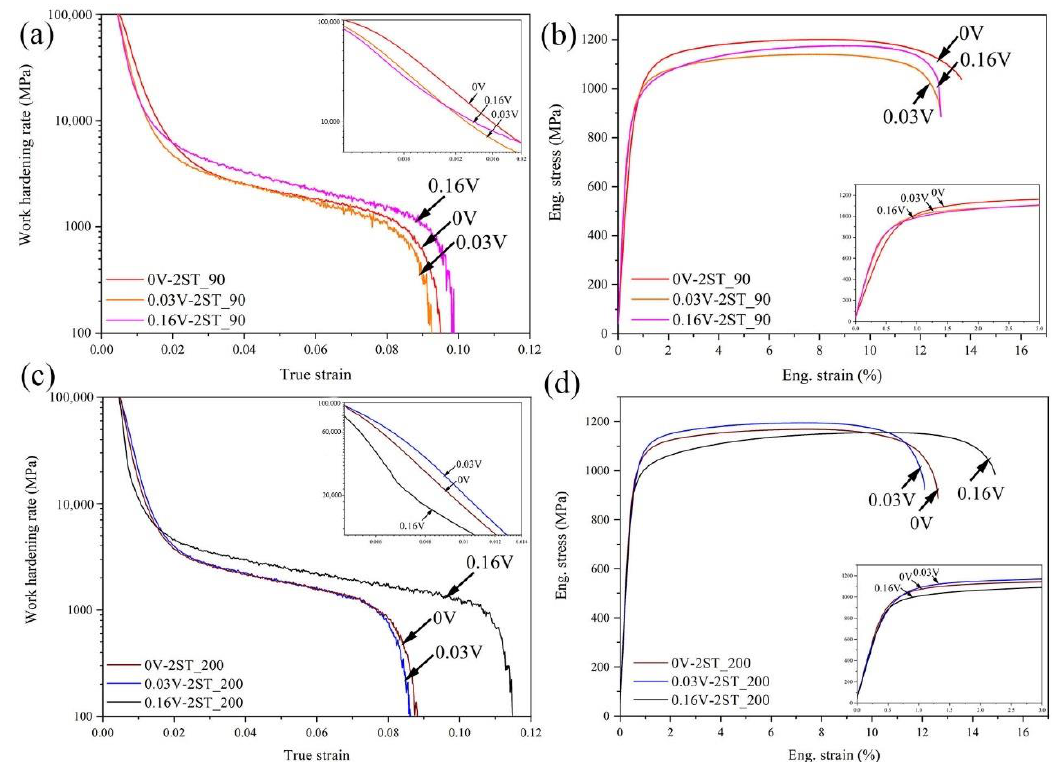
Figure 16. Comparisons of ( a , c ) true strain–work hardening rate and ( b , d ) engineering strain–stress curves of the three steels after two-step Q&P treatment.